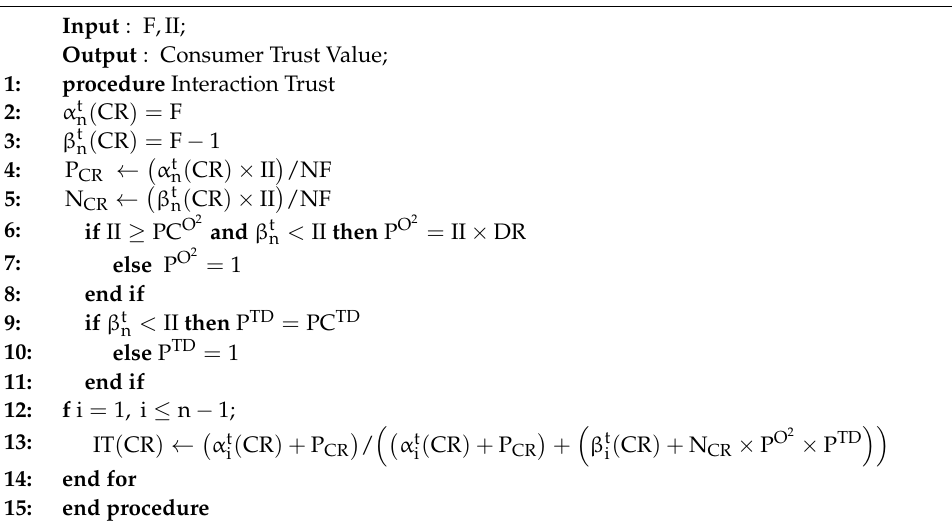
Algorithm 1 On/off Attack